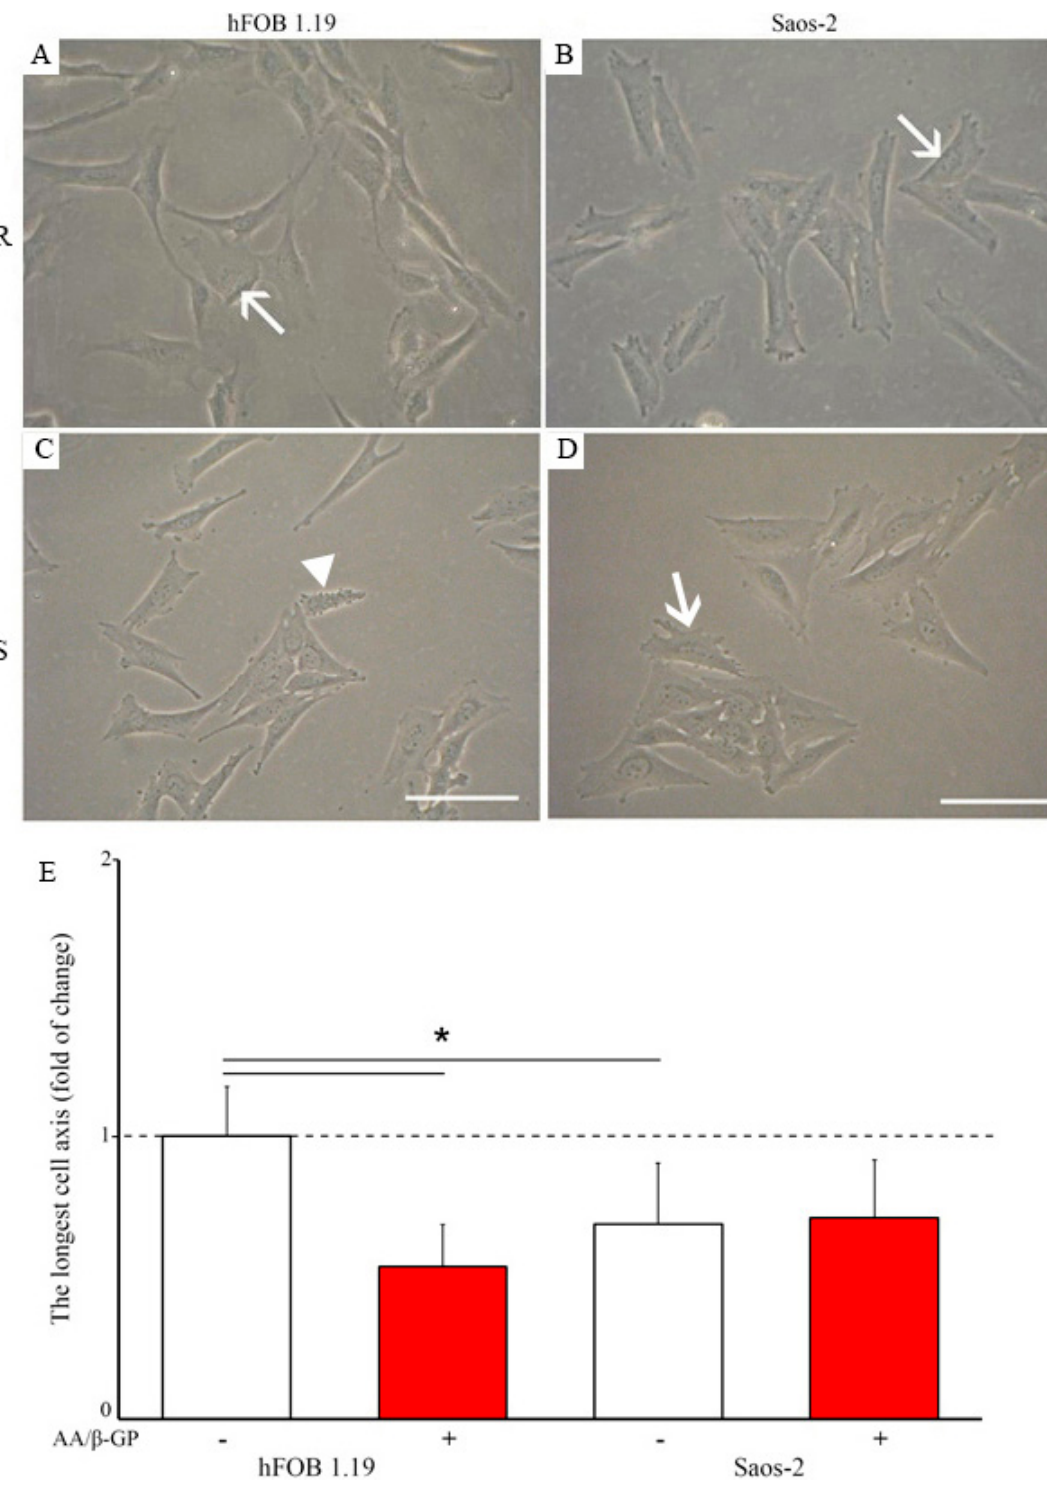
Figure 1. Morphology of hFOB 1.19 ( A , C ) and Saos-2 ( B , D ) cells in resting ( A , B ) and stimulated ( C , D ) conditions. Longest cell axis of cells in resting conditions (white) or after seven-day stimulation with ascorbic acid (AA) and β -glycerophosphate ( β -GP) (red) observed under an Axiovert 40C light microscope (Carl Zeiss, Poznan, Poland) with Phase contrast, magnification at 120×. Arrows indicate an elongated cell morphology, whereas the arrowhead—a shortened cell axis. ( E ) In total, 500 cells were analyzed: 10 photographs were taken at each of five random locations of a 100 mm diameter dish, and the longest axis of 10 cells at each location was measured for each cell variant using Image J bundled with 64-bit Java 2.8.0_112 software (Bethesda, MD, USA) and presented as the fold of change of the longest axis of hFOB 1.19 resting cells; * p <